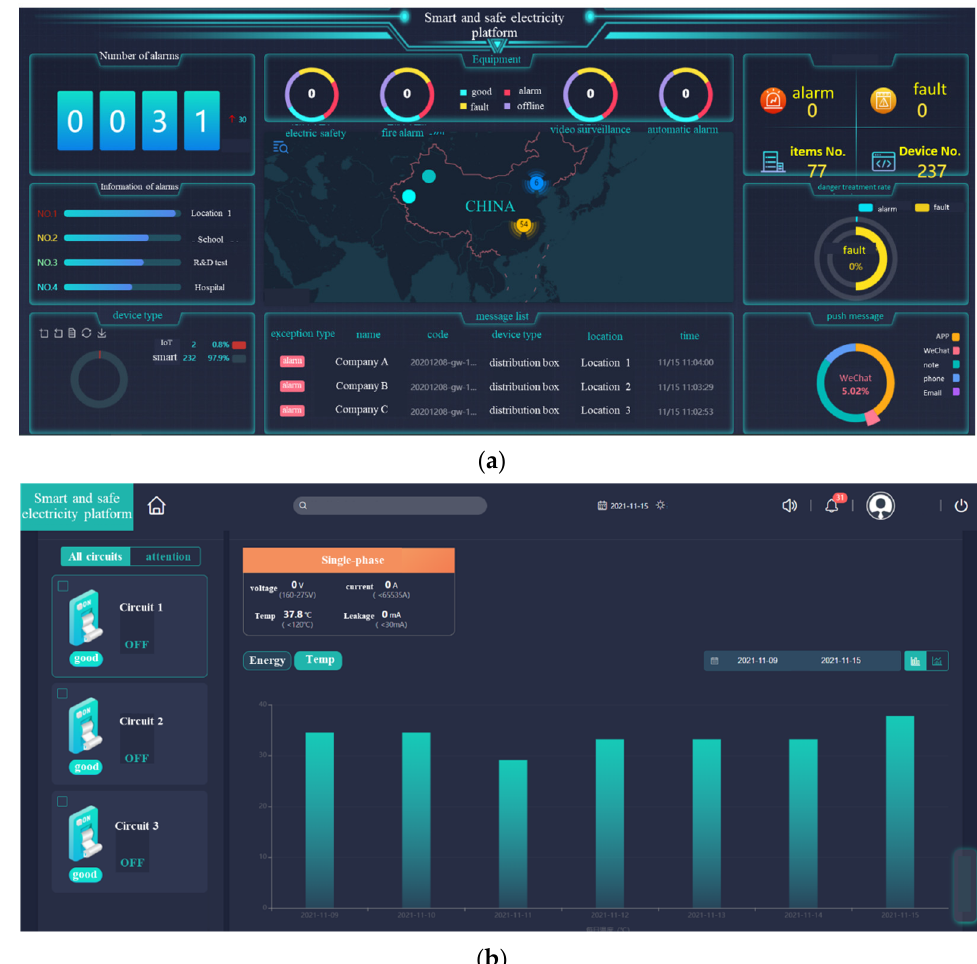
Figure 9. Circuit breaker digital monitoring system. ( a ) The main interface. ( b ) Circuit breaker monitoring interface.